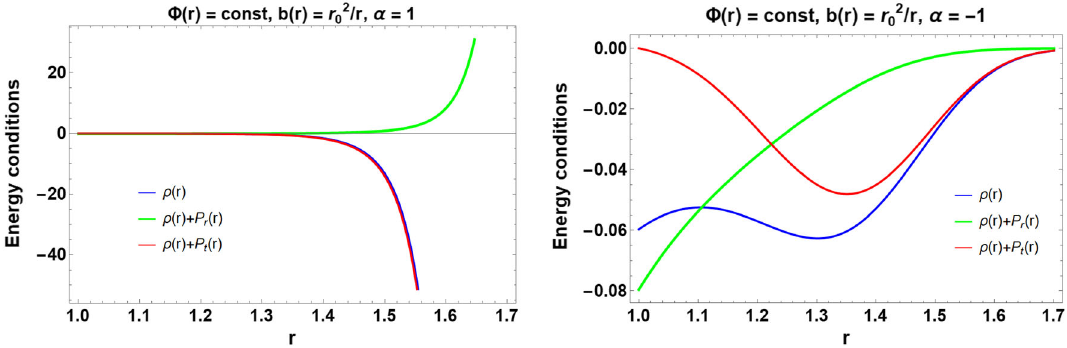
Fig. 3 With r 0 = 1 and α = ± 1, we plot ρ , ρ + P and ρ + P ⊥ for the specific case of f ( Q ) = Q